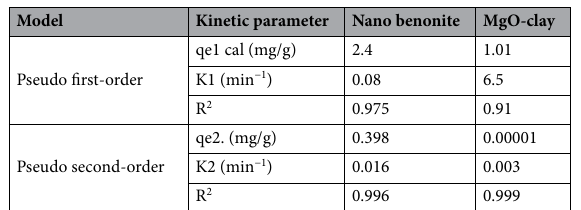
Table 5. Kinetic parameters for the adsorption MG onto nano bentonite and MgO impregnated clay.